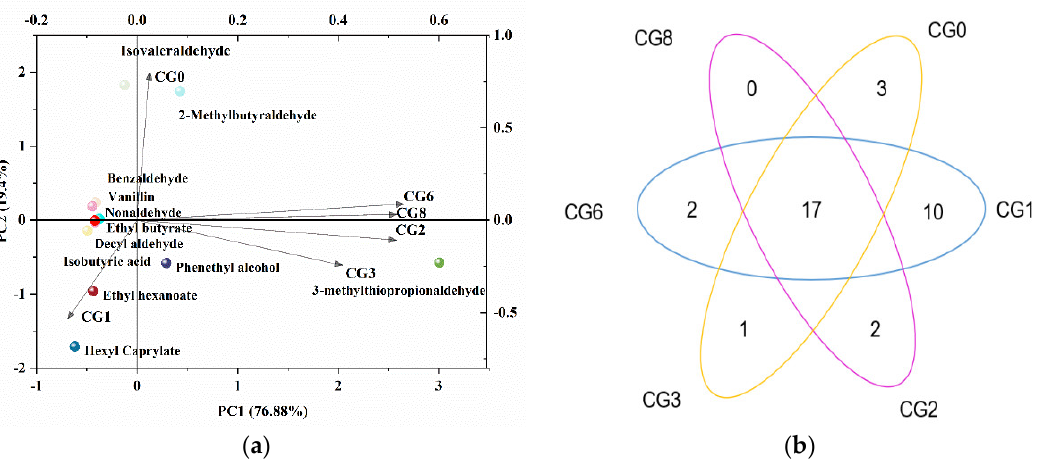
Figure 1. Venn ( a ) and PCA ( b ) analysis of characteristic VFCs of Caishiji soybean paste in different fermentation stages. The samples were coded according to Section 2.